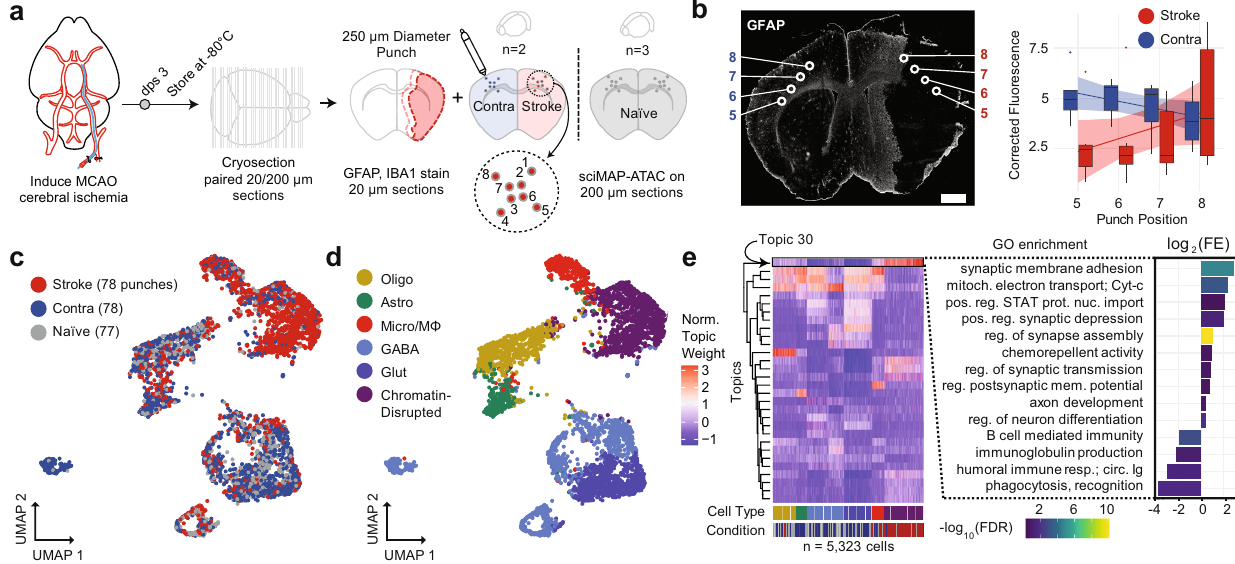
Fig. 7 sciMAP-ATAC applied to a mouse model of ischemic injury. a Experimental design using a mouse MCAO model of ischemic injury. Mice were sacri fi ced 3 days post surgery (dps) and brains fl ash-frozen in TFM. Alternating thin (20 µ m) and thick (200 µ m) sections were processed using IHC to de fi ne infarction (red outline) and peri-infarct area (pink outline) and sciMAP-ATAC punching schematic, respectively. b GFAP IHC of a 20 µ m coronal section of an ischemic mouse brain. Punch positions along the 5 – 8 axis (core-to-border) are indicated. Background corrected GFAP fl uorescence along the 5 – 8 axis is shown to the right for stroke and contralateral hemispheres ( n = 10). Data are presented as linear fi tted model ± SEM; boxplot center line represents median, lower and upper hinges represent fi rst and third quartiles, and whiskers extend from hinge to ±1.5 × IQR, (scale bar, 1 mm) c . UMAP of cells colored by the three conditions. d UMAP as in c , colored by clusters assigned to cell type (Olig oligodendrocytes, Astro astrocytes, Micro/M Φ microglia/macrophage, GABA GABAergic (inhibitory) neurons, Glut glutamatergic (excitatory) neurons). e Cell × topic matrix colored by normalized topic weights, as in c , d and annotated by conditions and cell type as given at the bottom reveals substantially divergent topic weighting in cells from the stroke punches (left). Topic 30, enriched speci fi cally in the stroke cells belonging to the chromatin-disrupted cluster, has peaks enriched for ontologies associated with ischemic injury with reperfusion. Colored by − log 10 false discovery rate (FDR) Q -value, height by log 2 fold enrichment (right). Source data are provided as a Source data fi